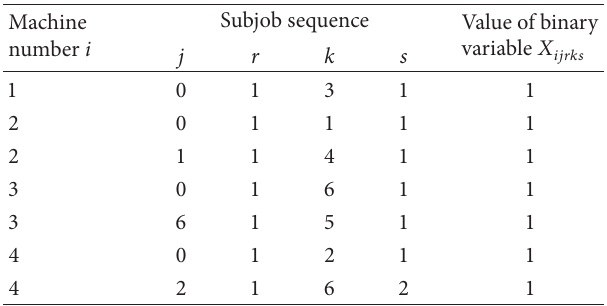
Table 5: Initial values for the binary variable set.